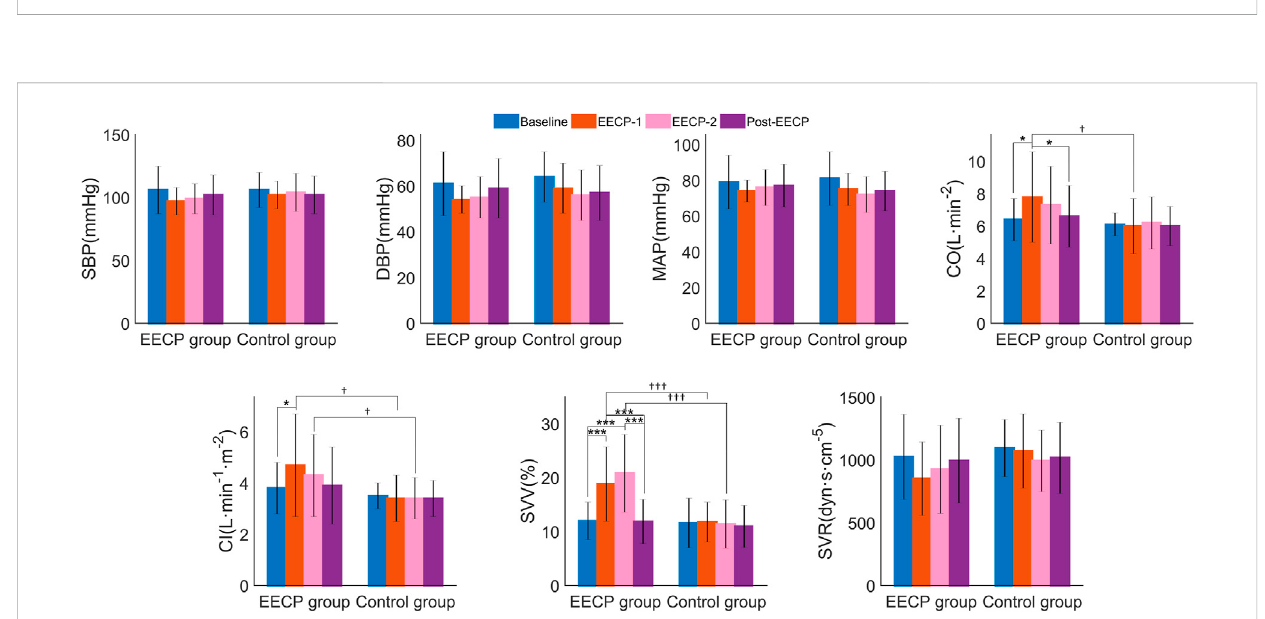
FIGURE 5 The hemodynamic parameters (values are mean ± SD) of subjects in active EECP and sham control groups before, during, and after two sessions of 30 minute-EECP. SBP, systolic blood pressure; DBP, diastolic blood pressure; MAP, mean arterial pressure; CO, cardiac output; CI, cardiac index; SVV, stroke volume variability; SVR, systemic vascular resistance. † p < 0.05, ††† p < 0.001 (active EECP group compared to sham EECP group); p -values for within-group or inter-group comparisons were tested by two-way repeated measures ANOVA with Bonferroni post hoc analysis. * p < 0.05, *** p < 0.001 (comparison among EECP intervention phases in active EECP